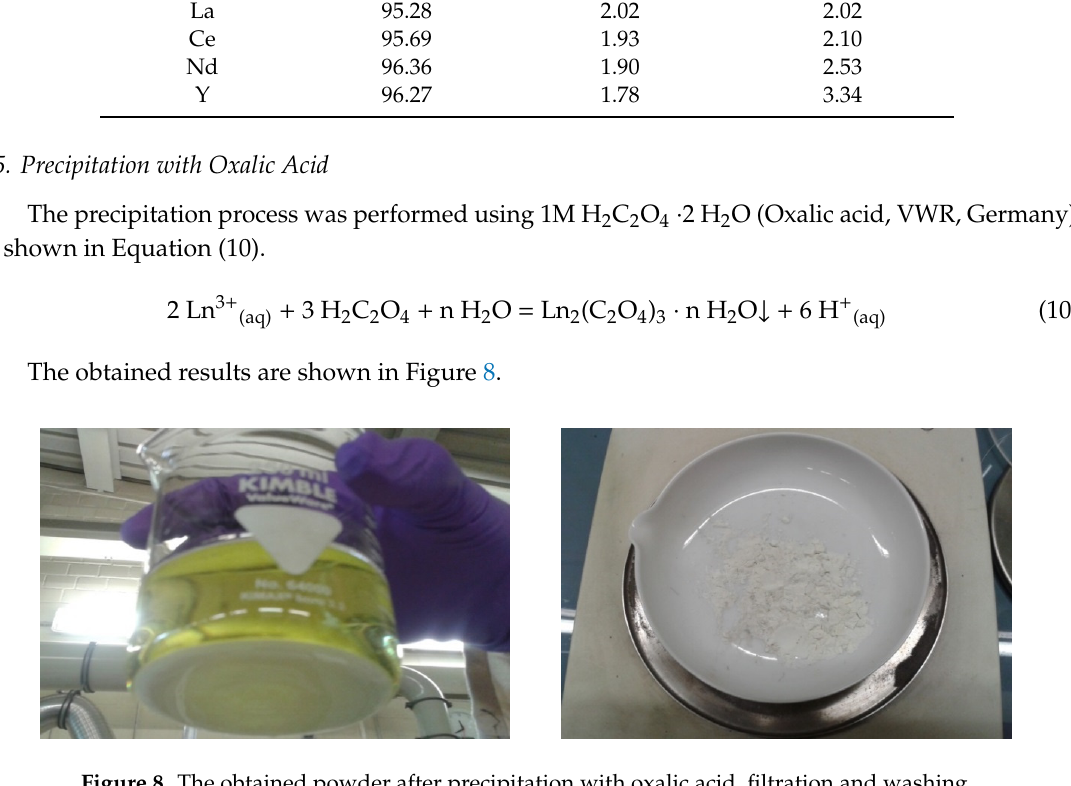
Table 6. The rare earth elements distribution in filtrate, wastewater 2 and solid residue (Experiment. 6).